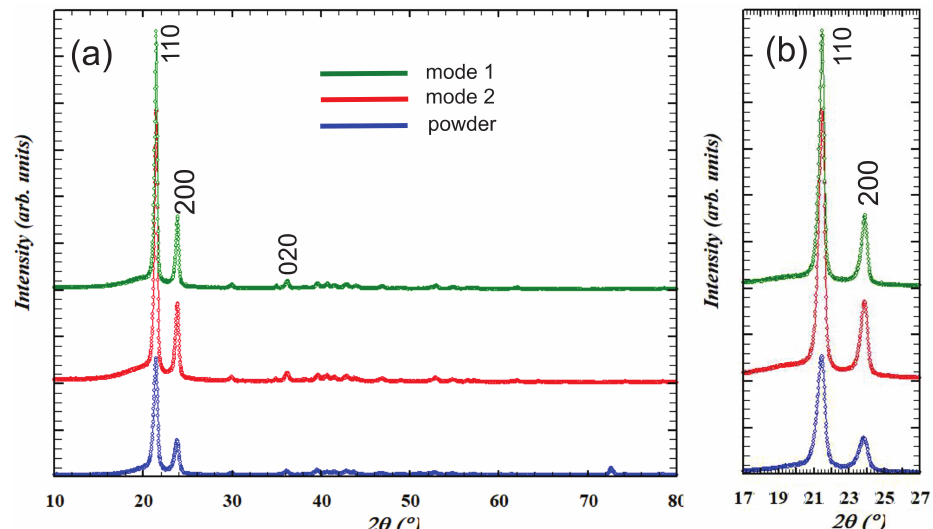
Figure 16. ( a ) X-ray diffraction patterns of UHMWPE coatings. ( b ) Complete range of determination of the degree of crystallinity.